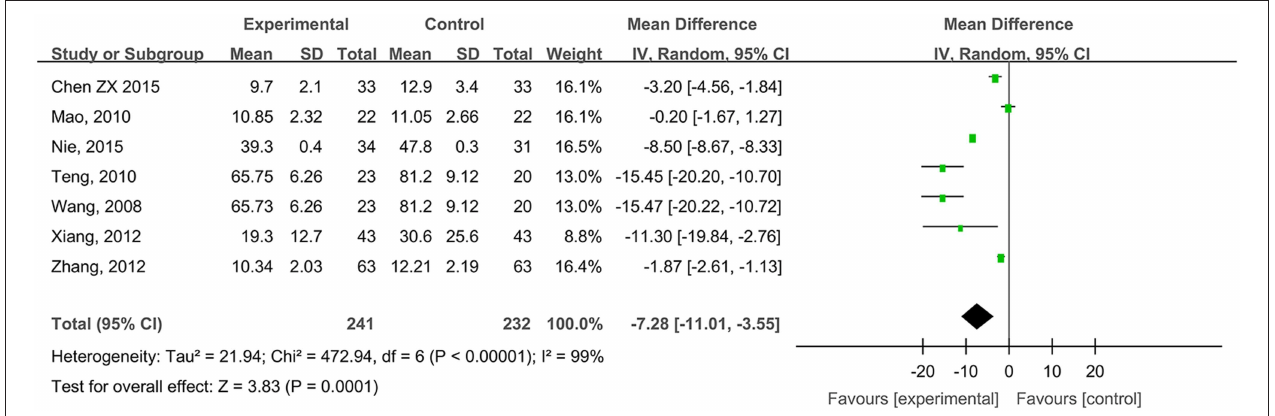
FIGURE 5 | Comparative meta-analysis of wound healing times of diabetic foot ulcers.